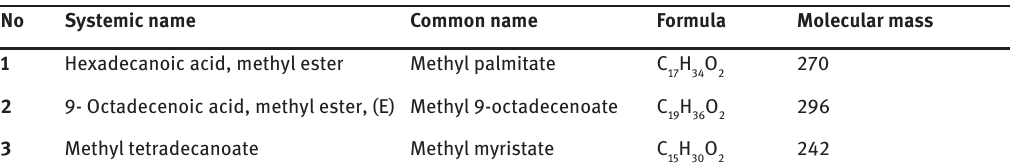
Table 2: GC-MS analysis of sample product using calcined CaO as catalyst. No